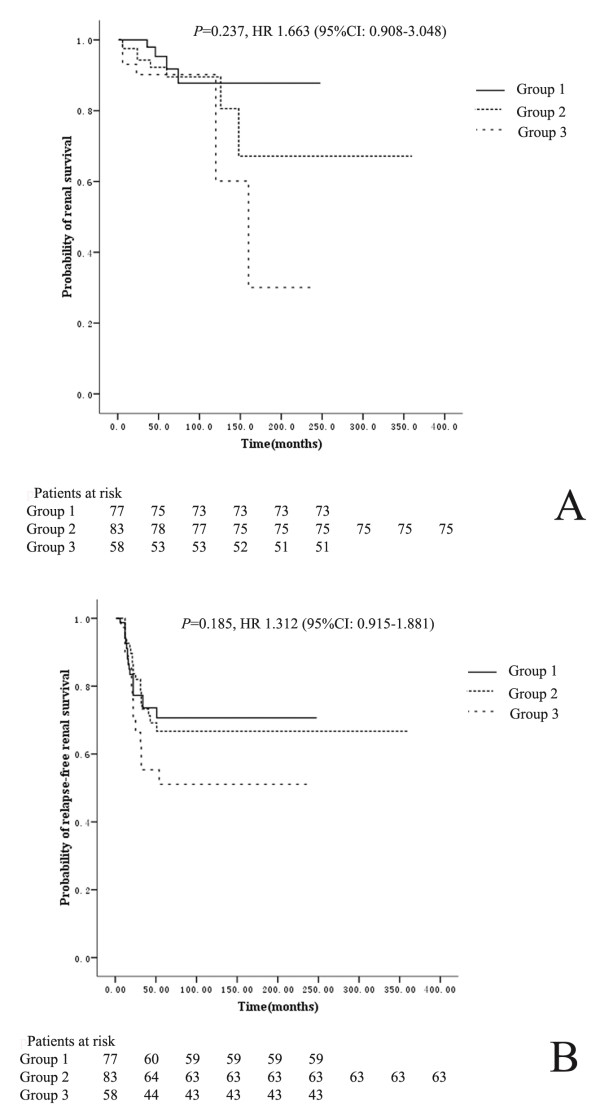
Comparison of renal outcomes and relapse-free renal survival among patients with different levels of C1q. A. Comparison of renal outcomes among patients with different levels of C1q; B. Comparison of relapse-free renal survival among patients with different levels of C1q. Group 1.patients with “normal C1q” (> 40 μg/ml); Group 2. patients with “low C1q” (20–40 μg/ml); Group 3. patients with “very low C1q” (<20 μg/ml).